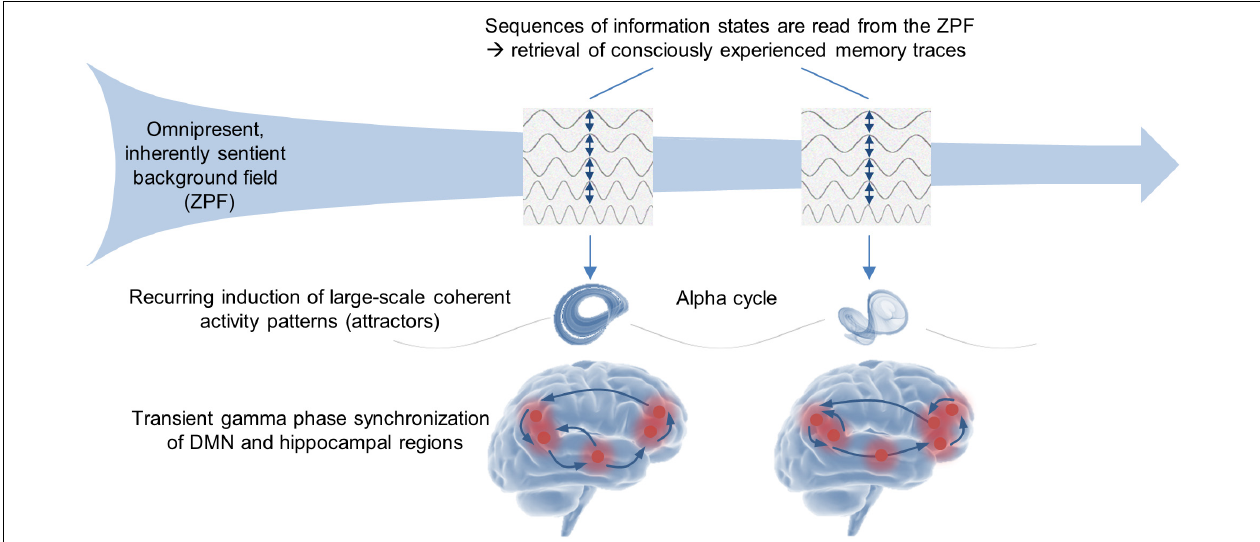
FIGURE 3 | Stimulus-independent operating mode of the brain. The experimental insights suggest that the retrieval of declarative memories and the stream and self-referential consciousness rest on one and the same fundamental mechanism. In concrete terms, the recall of each individual event of a memory trace is based on transient gamma phase synchronization of DMN and hippocampal regions, while the recurring integration and disintegration of the synchronously oscillating cell assemblies is reflected in the alpha rhythm. Interpreted from the viewpoint of the SED-based conceptual framework, the brain is receptive to previously generated sequences of ZPF information states that constitute existing memory traces, with each ZPF information state inducing a phase transition that results in a large-scale coherent DMN-hippocampal activity pattern (attractor). Accordingly, the empirical body of evidence supports the hypothesis that in the stimulus-independent operating mode the brain retrieves consciously experienced memory traces by reading sequences of information states from the ZPF.